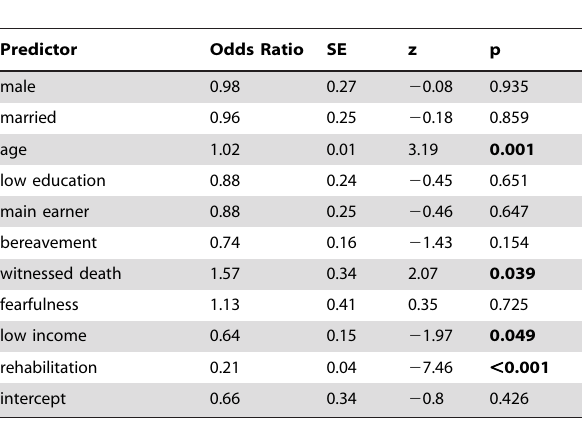
Table 2. Logistic regression of Physical Dysfunction on Selected Predictors.